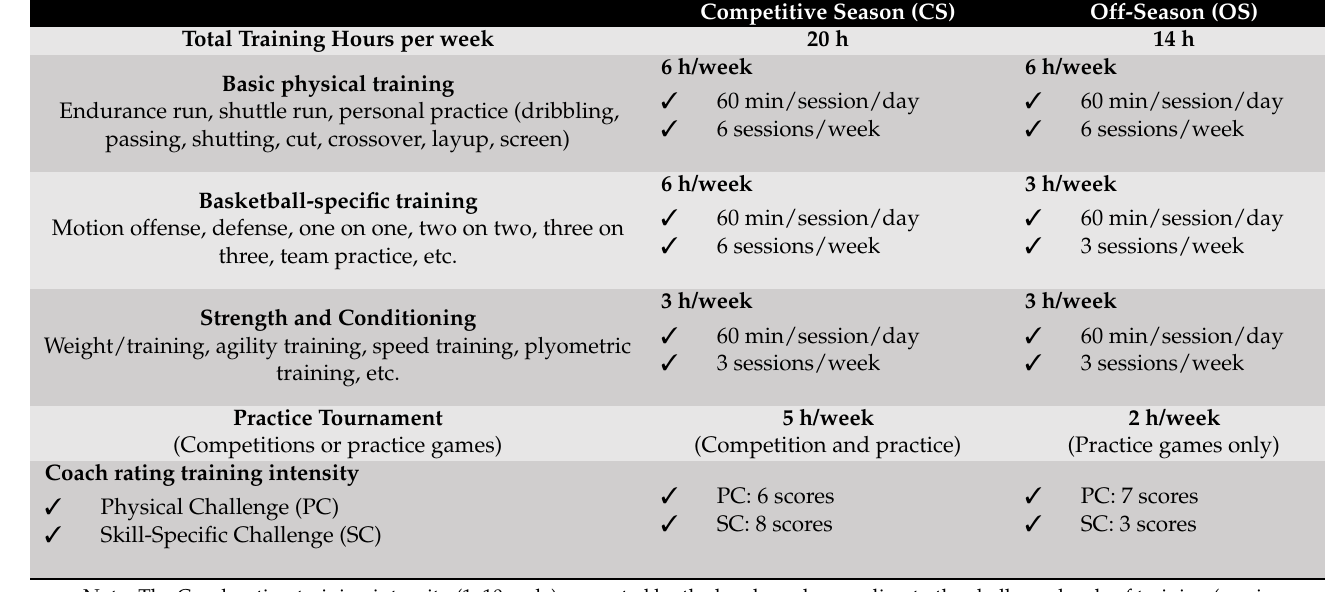
Table 2. Training programs for the competitive season and off-season.